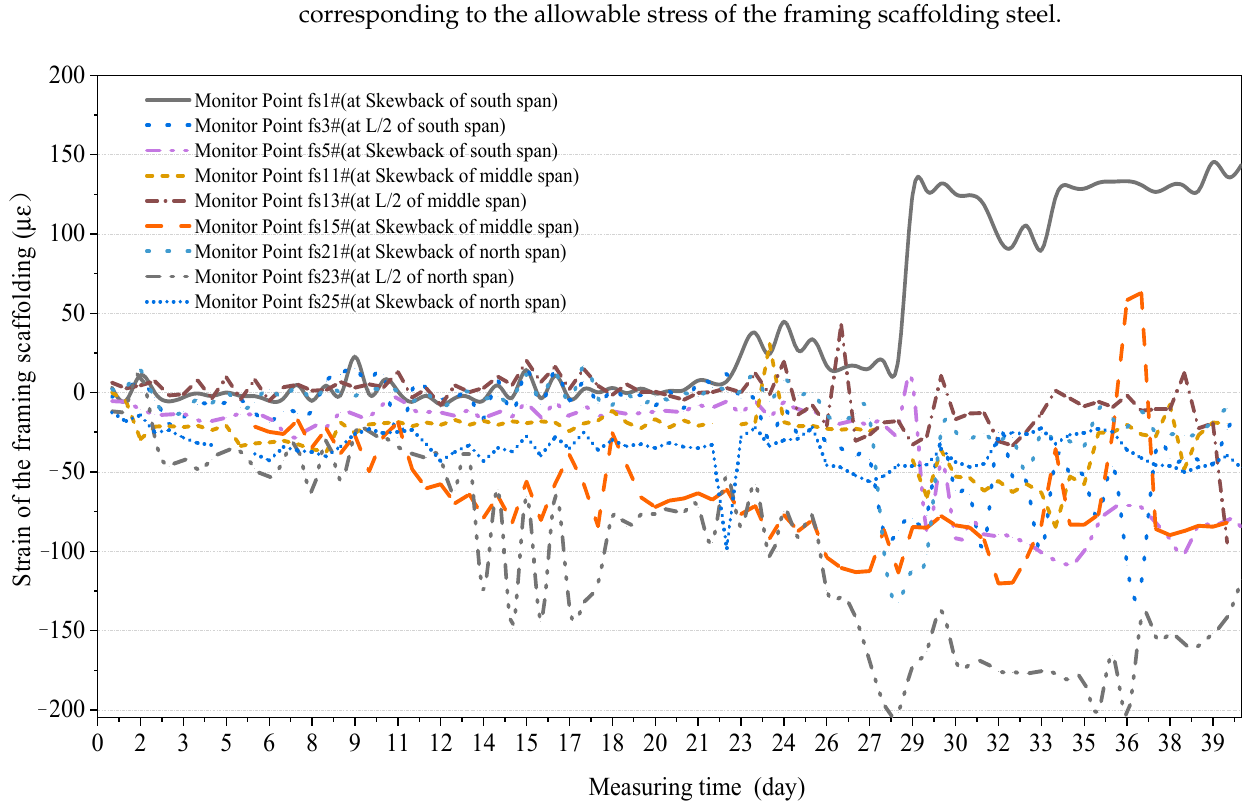
Figure 14. Monitoring results of the strain on the arch ribs.